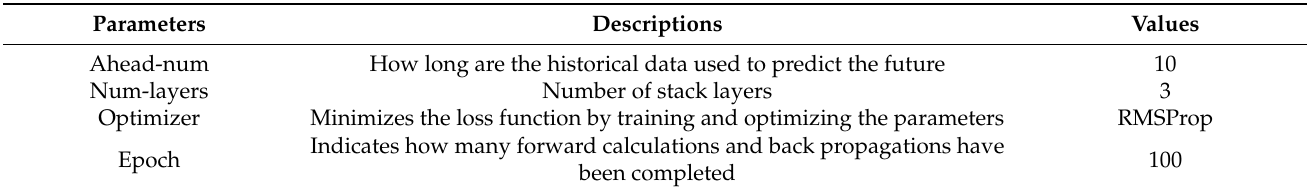
Table 1. Required parameters in RNN and GRU.